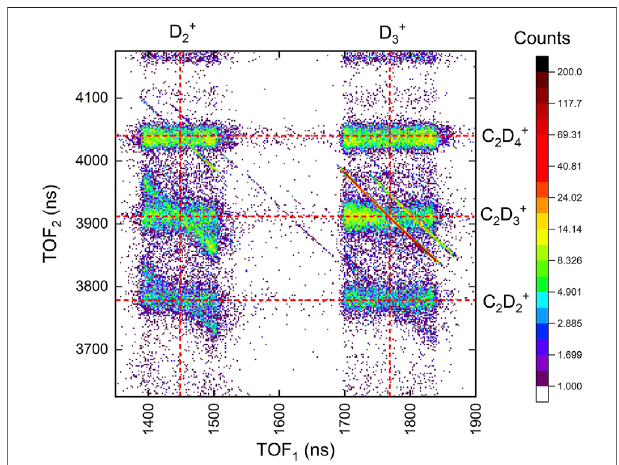
FIGURE 5 | The portion of the coincidence-time-of- fl ight map of two- body channels including D + 2 and D + 3 fragments from C 2 D 6 exposed to a 25-fs, 790-nm, 1.5 × 10 14 W/cm 2 laser pulse.